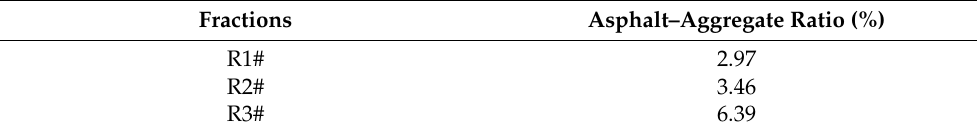
Table 3. Asphalt–aggregate ratios of